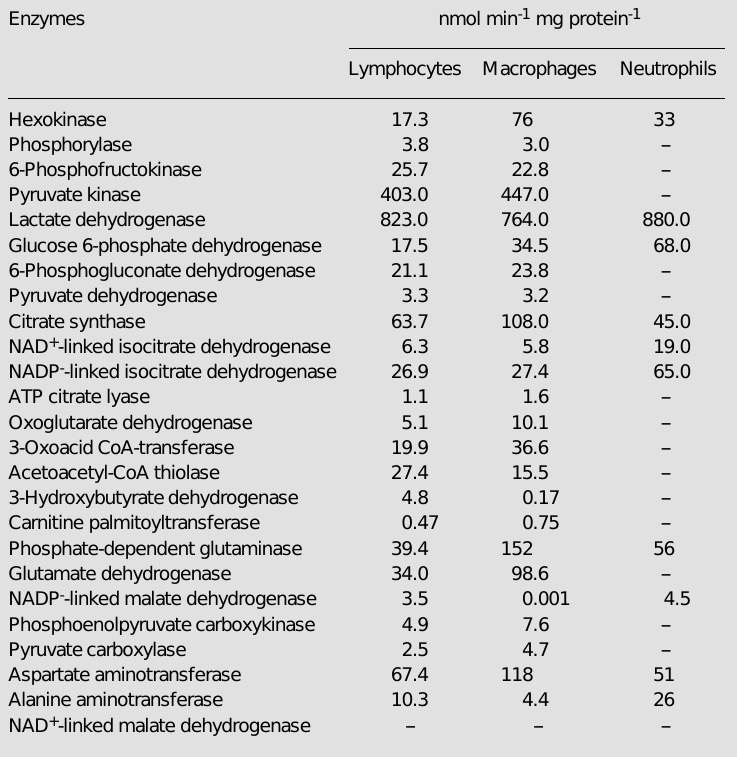
Table 1 - Maximum activities of glucose-, fatty acids, ketone bodies and glutamine- metabolizing enzymes in rat macrophages, lymphocytes and neutrophils. Lymphocytes and macrophages were prepared and extracted and enzymes were assayed as described by Newsholme et al. (4) and neutrophils as described by Pithon- Curi et al. (6). Activities were measured at 25 o C, except for glutaminase and phospho- enolpyruvate carboxykinase (37 o C). The results are from Newsholme et al. (4), Curi et al. (7) and Pithon-Curi et al.